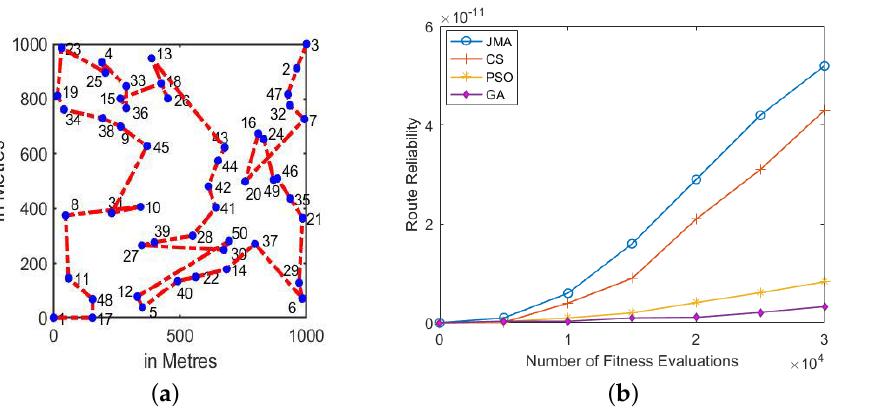
Figure 8. High Vehicular Density (50 vehicles). ( a ) Best route discovery achieved using JMA; ( b ) Mean route reliability results achieved across 1000 Monte Carlo